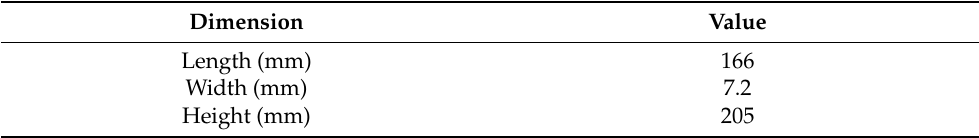
Figure 6. ( a ) Structure of the battery module; ( b ) model used for calculation. Table 6. Dimensions of the coolant channel.